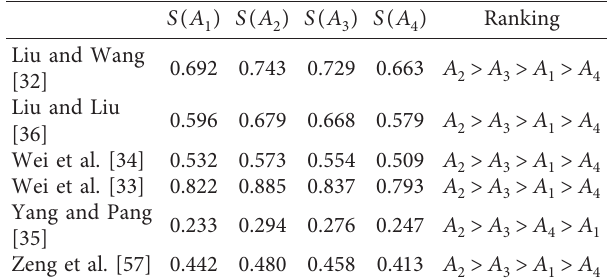
Table 5: Score values and ranking order of the existing